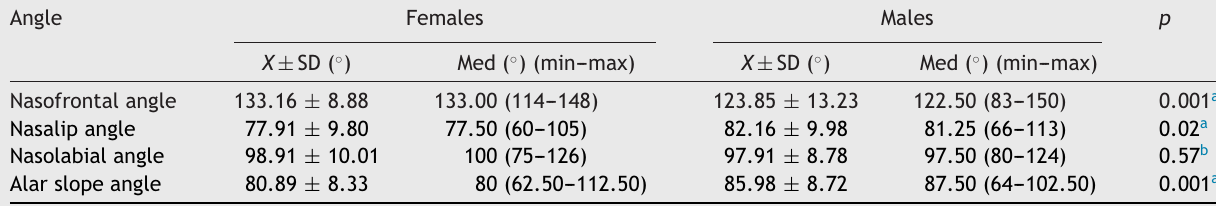
a Significant. b